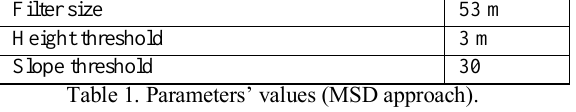
Table 1. Parameters’ values (MSD approach).